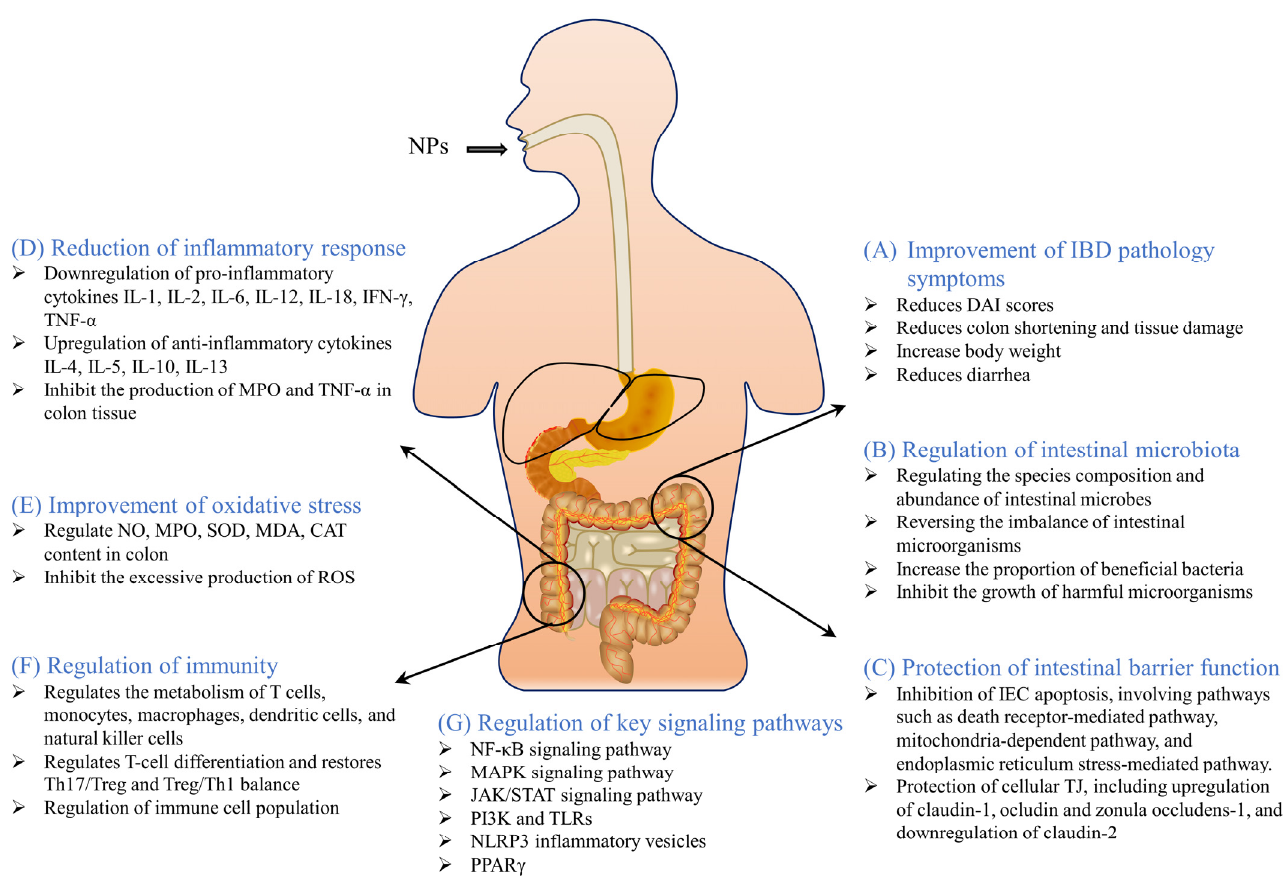
Figure 11. Mechanism of therapeutic action of NPs for IBD. ( A – F ) are the main pathways of action of NPs for the treatment of IBD; ( G ) is a relevant signaling pathway for NPs to improve IBD.